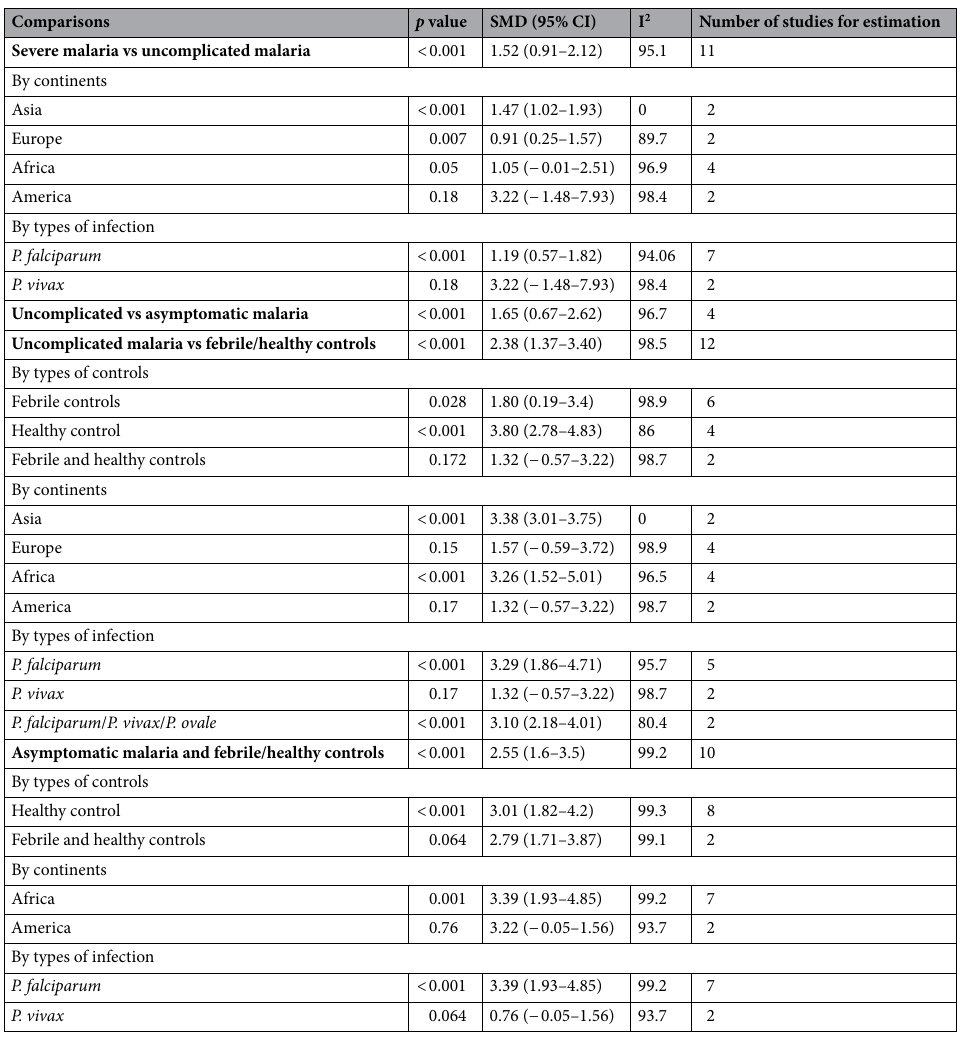
Table 2. Summary of